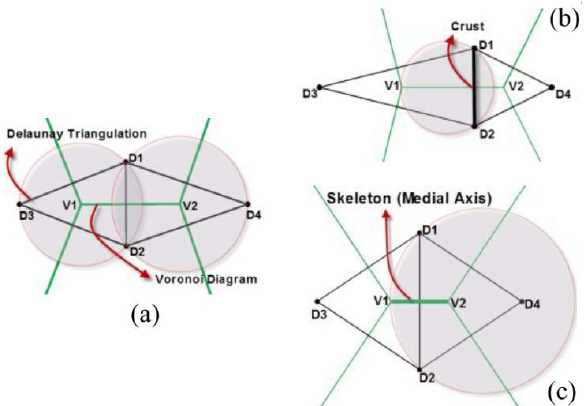
Figure. 1. Definition of the fundamental geometric structures used by the proposed method: (a) Delaunay triangulation and Voronoi diagram of four sample points D1 to D4; (b) V2 is outside the circle passes through D1, D2 and V1, so D1D2 belongs to the crust; (c) V2 is inside the circle passes through D1, D2 and V1, so V1V2 belongs to the